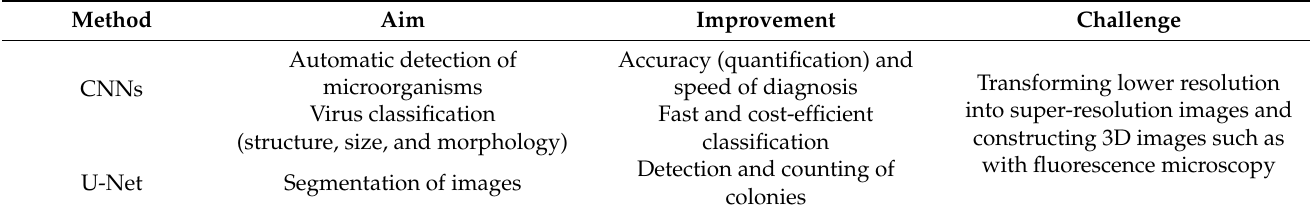
Table 3. Algorithms used in microbiology, with their usability and the corresponding improvement in the field.